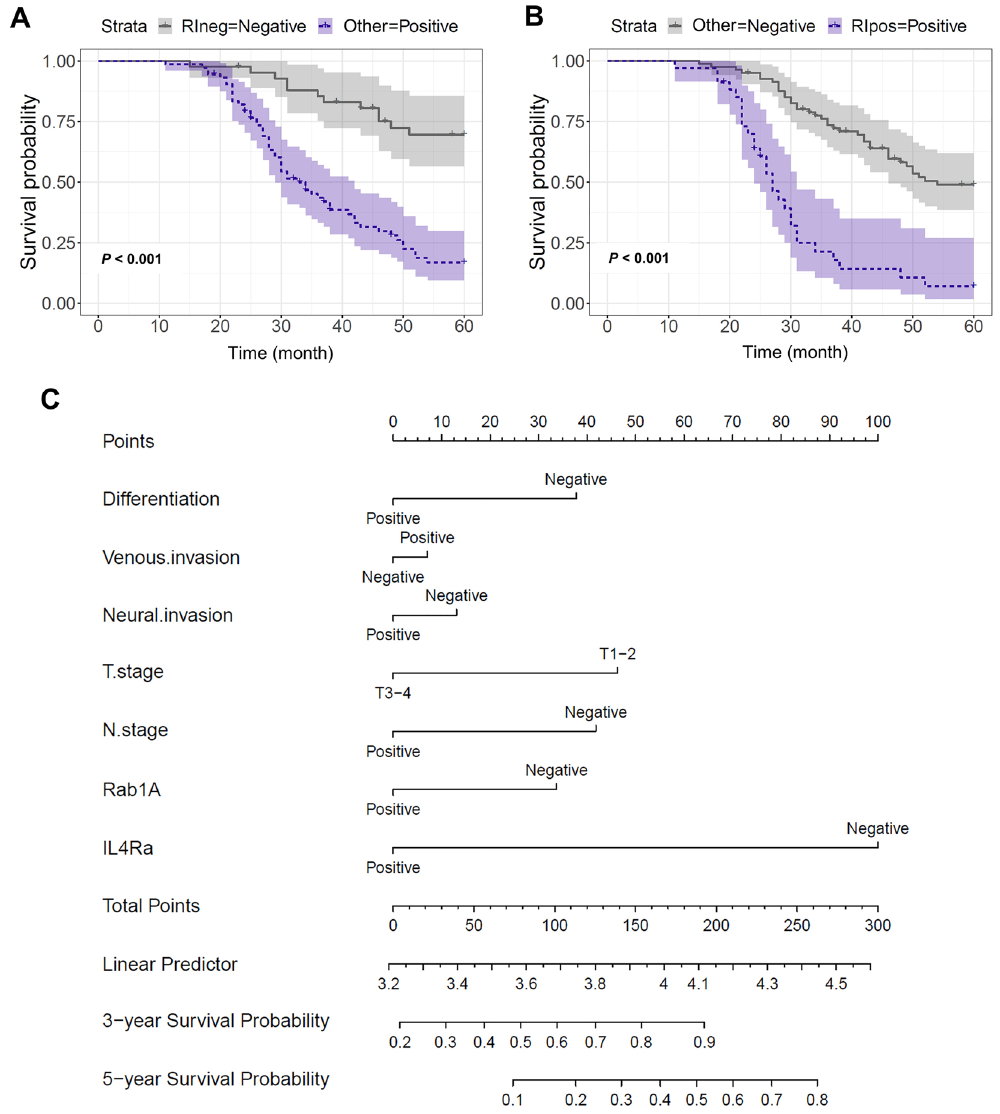
Figure 5. Nomograms predict 3 and 5-year overall survival of GC patients. The nomogram point scale helped predict the 3 and 5-year overall survival rates predicted using the total points associated with each prognostic